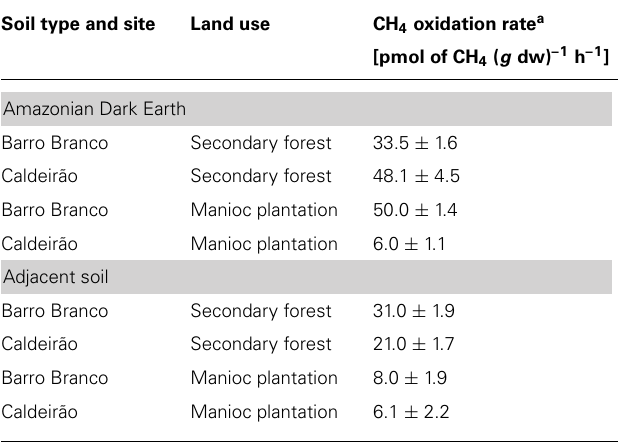
Table 2 | CH 4 oxidation rates inAmazonian Dark Earth and their adjacent soils under secondary forest and manioc cultivation. Soil type and site